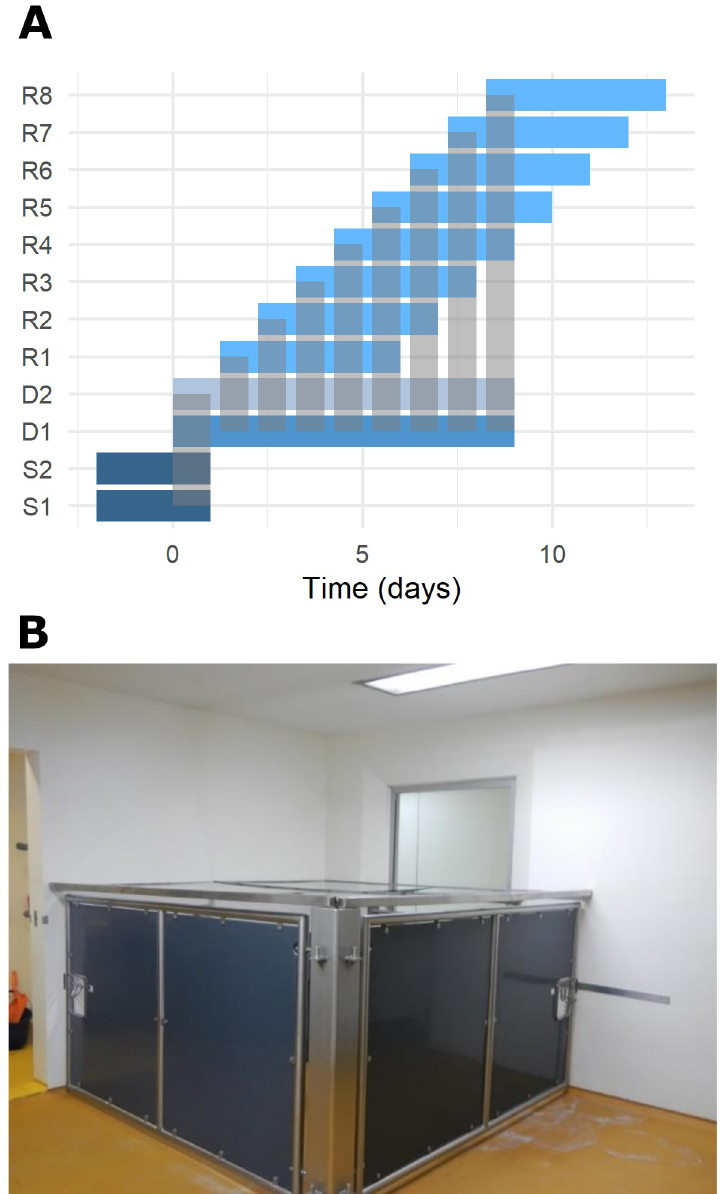
Fig 1. Experimental design. A) Two seeder (S1 and S2) pigs were infected with MAD device and put in contact 2 days later with two donor (D1 and D2) pigs. After 24 h the seeders pigs were culled and one of the donor pig (D1) is put in contact with a different recipient pig (R1-R8) for 18hr (between 2 pm and 8 am). During the remaining 6hr, D1 is co- housed with donor pig 2 (D2). Recipient pigs were sampled daily during 6 days. Each grey rectangle shows a contact, between S and D and between D and R. B) Contact chamber in which donor and recipients were co-housed for 18 hours every